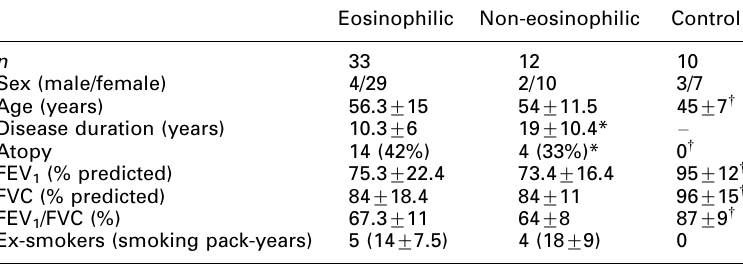
Table 1. The clinical characteristics of the study population